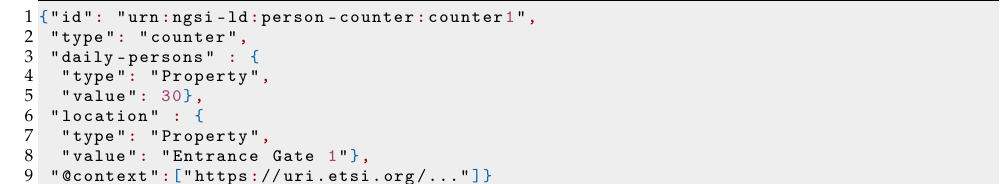
Table 1. NGSI-LD Entity representing a person counter’s